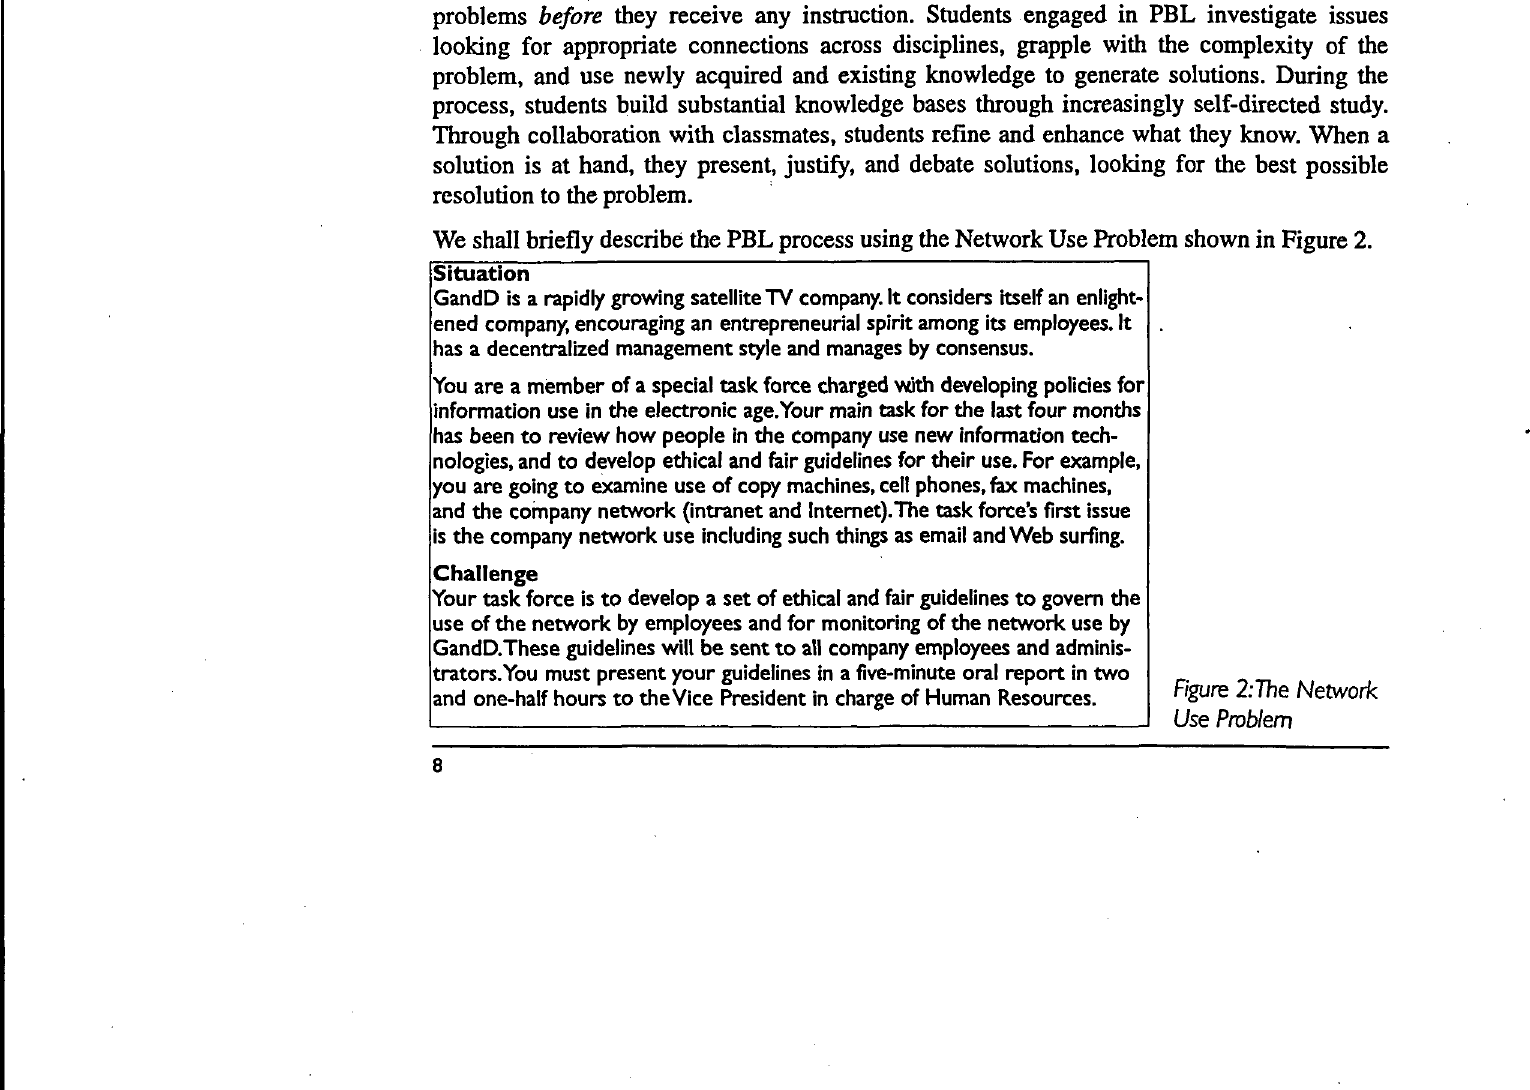
Figure 2: The Network Use